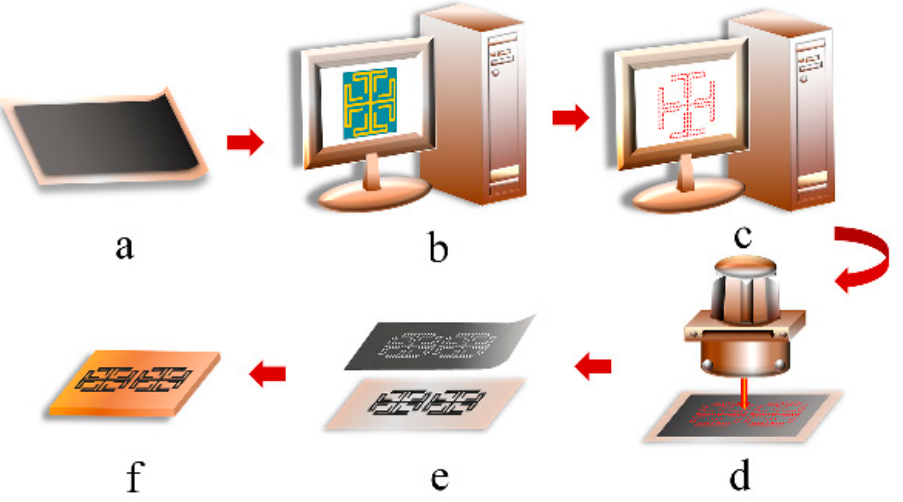
Figure 3. Fabrication scheme of the HCGF FSS. ( a ) Hot pressing of the HCGF onto the polytetrafluoroethylene (PTFE) substrate. ( b ) Exportation of the contour FSS from the simulation tool. ( c ) Importation of the contour file into the laser engraving software for laser path calculation. ( d ) Laser engraving process to cut the path. ( e ) Removal of the unwanted HCGF and detachment of the patterned HCGF from the PTFE substrate. ( f ) Transfer of the patterned HCGF to the FR4 substrate by